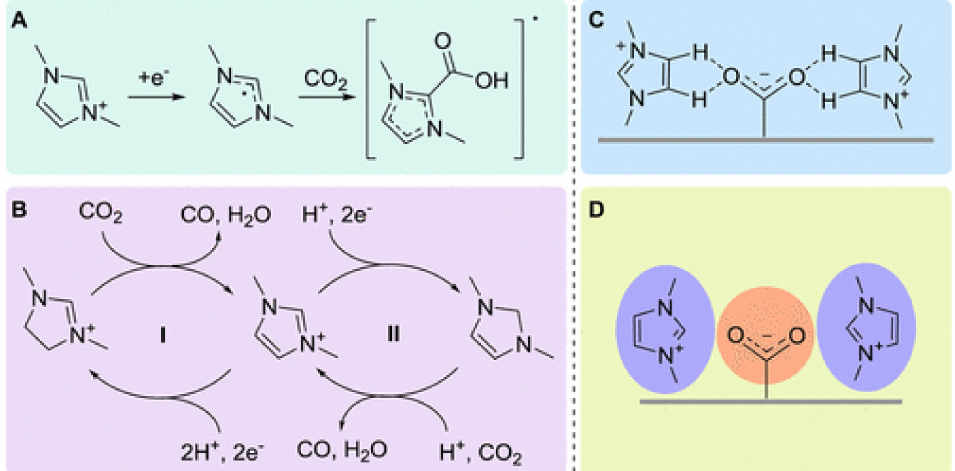
Figure 8. Mechanisms proposed regarding the role of IL as co-catalysts in the CO 2 RR. Left: covalent activation. ( A ) Generation of a covalent bond between CO 2 and the imidazolium IL. ( B ) Im IL as a hydride/proton donor reducing CO 2 . Right: non-covalent activation. ( C ) Stabilization of CO 2 •− by hydrogen bonding. ( D ) Stabilization of CO 2 − through the adjustment of the local electric field. Reprinted with permission from [104]. Copyright 2014, American Chemical